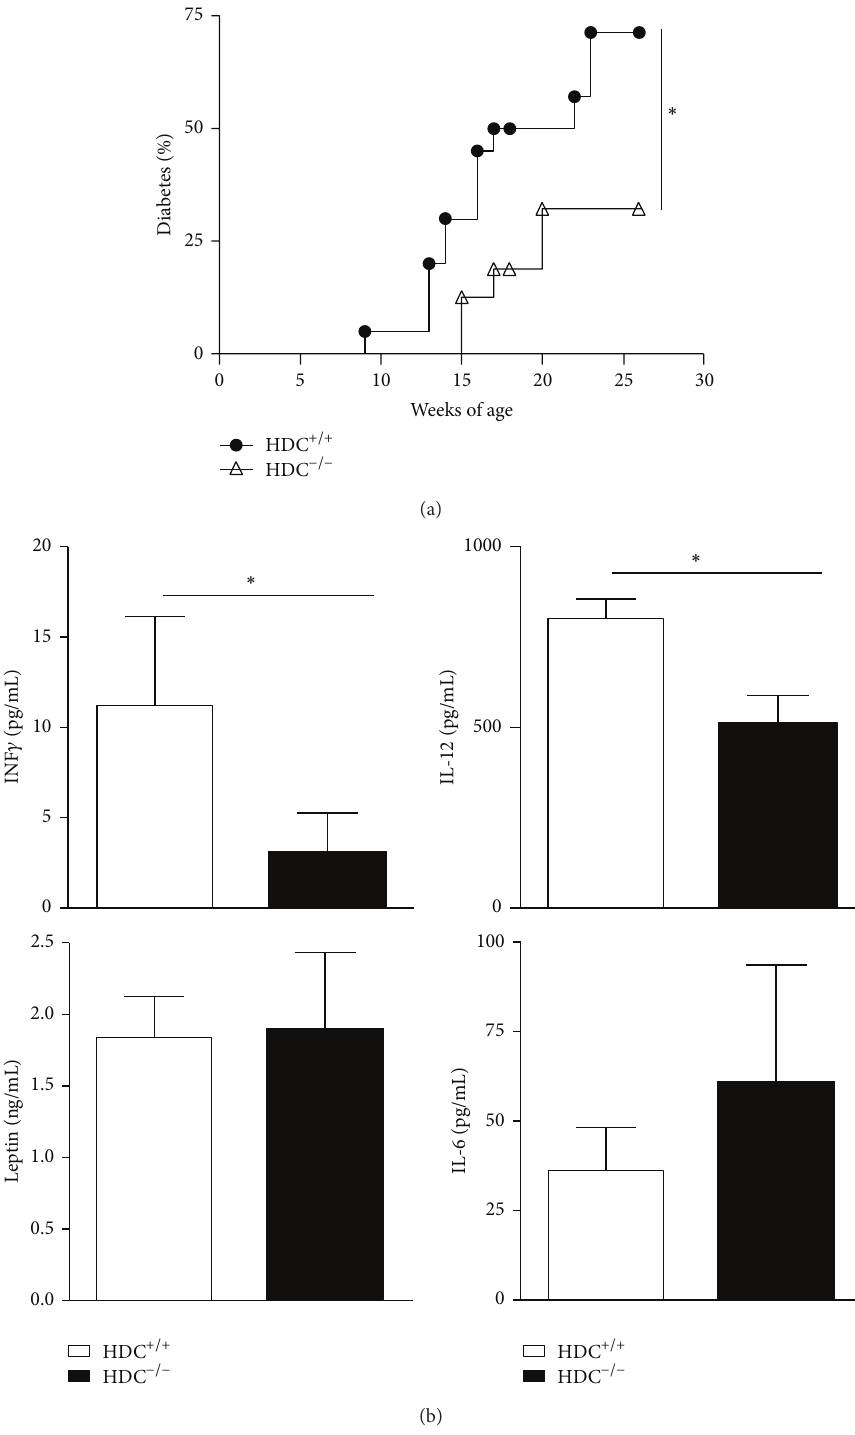
Figure 1: HDC −/− mice are partially resistant to the development of autoimmune diabetes. (a) Cumulative incidence of spontaneous diabetes in female HDC +/+ ( 𝑛 = 22 ) and HDC −/− strains ( 𝑛 = 20 ). Mice were considered diabetic when glycemia > 2.5 g/L. (b) Serum levels of IL-6, IFN 𝛾 , IL-12, and leptin in HDC −/− NOD and NOD female mice. For measuring leptin, serum was obtained from starved mice. Data are presented as means ± s.e.m. ∗ 𝑃 < 0.05 , HDC −/− versus HDC +/+ mice determined by Student’s 𝑡 -test. ( 𝑛 = 8